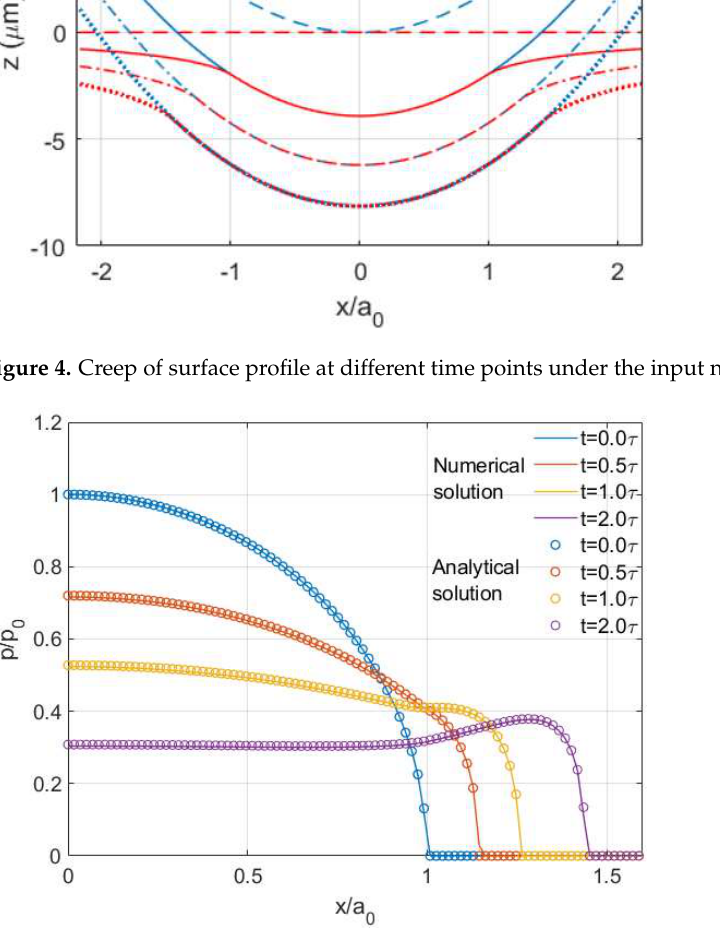
Figure 5. Normalized pressure p for the viscoelastic sphere contact (Maxwell model).